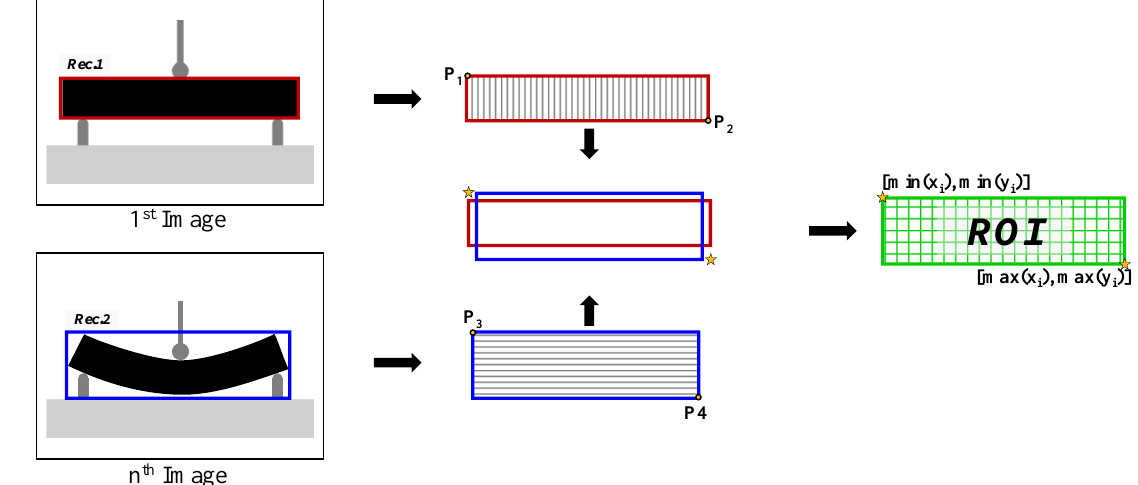
Figure 3. ROI generated by combining two rectangles.